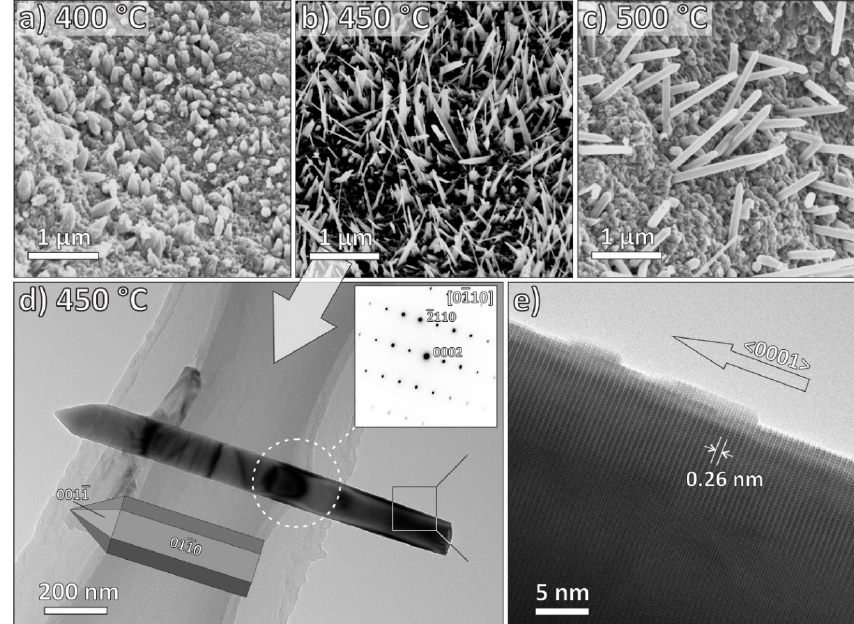
Figure 3. ( a – c ): SEM images of ZnO nanostructures synthesized at different growth temperatures: ( a ) 400 °C, ( b ) 450 °C, and ( c ) 500 °C, respectively; time period of growth was 30 min. ( d ) TEM micrograph of a single-crystalline ZnO NW grown at 450 °C with the corresponding SAED pattern (inset) and a model of crystal in the corresponding orientation. ( e ) High-resolution TEM micrograph of a ZnO nanowire, with the marked interplanar spacing of 0.26 nm. The NW is elongated in the <0001> direction.